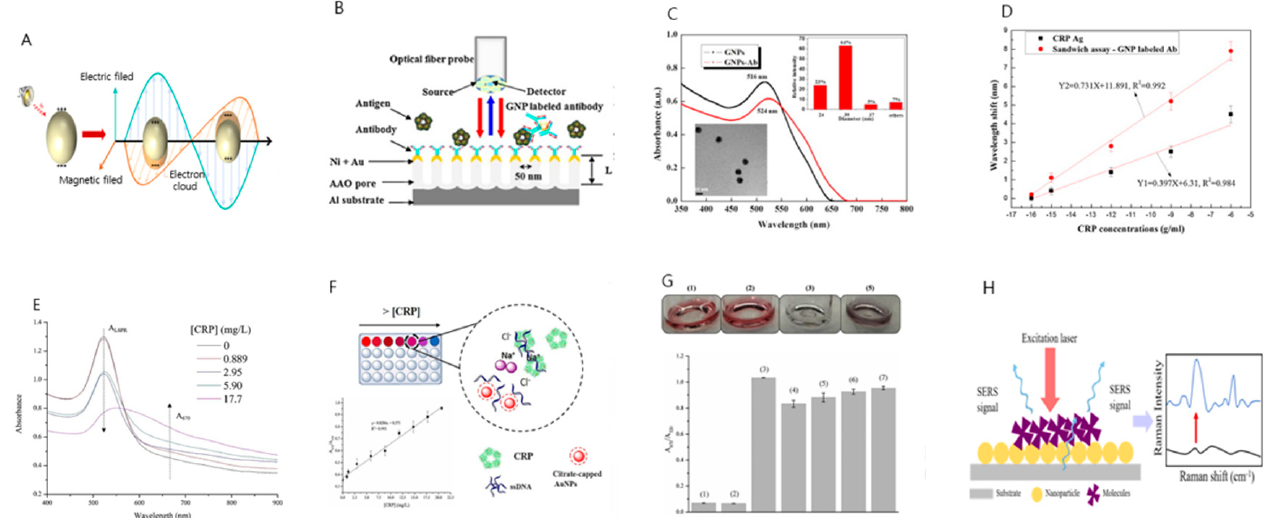
Figure 3. ( A ) Local surface plasmon resonance (LSPR) basic structure. ( B ) Schematic cross-sectional view showing the structure of an AAO chip fabricated for CRP antigen detection. ( C ) Absorption spectra of gold nanoparticle (GNP) and GNP-labeled CRP antibodies. ( D ) CRP antigen–antibody response (black), and linear regression of the resonant wavelength shift after GNP-labeled CRP secondary antibody reaction (red). ( E ) Overall schematic diagram of CRP detection method. ( F ) (1) AuNP colloid, (2) Bottom-ratio value of Apt-AuNPs Set it. (3) Add CRP 17.7 mg/L and then Au colloid, (4) CRP 17.7 mg/L Apt-AuNPs, (5) NaCl (60 µ L, 0.2 M) after addition (4), (6) (4) CRP Same as 20.7 mg/L, (7) (5) same as CRP 20.7 mg/L; Photos of (1), (2), (3) and (5), ( G ) UV-vis absorbance spectra of top samples of colloids of Apt-AuNPs for CRP addition at various concentrations. ( H ) Surface-enhanced Raman spectroscopy (SERS) basic principle (Reproduced with permission from [105,108] published by Elsevier 2013, 2020).